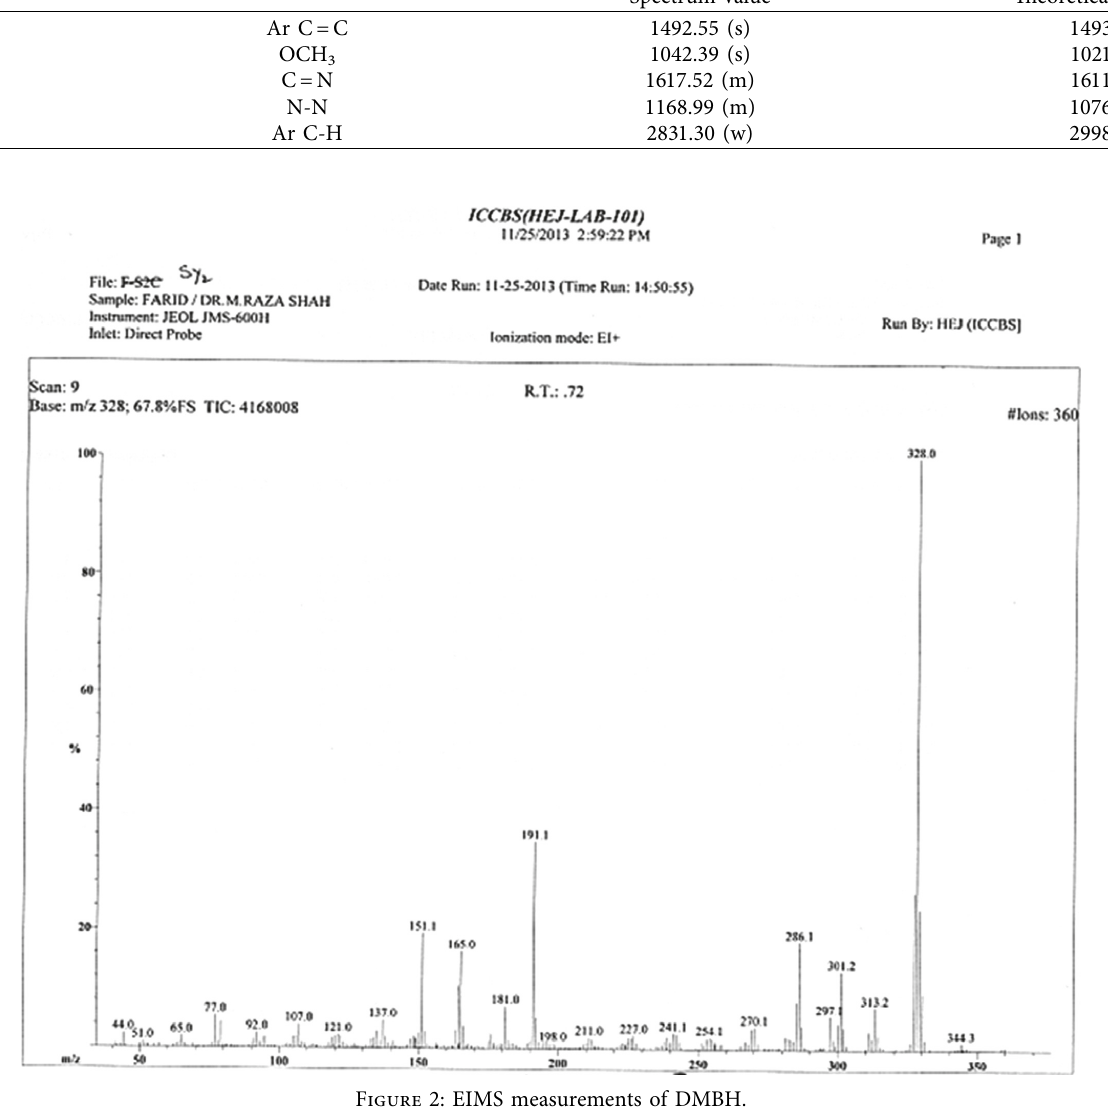
Figure 2: EIMS measurements of